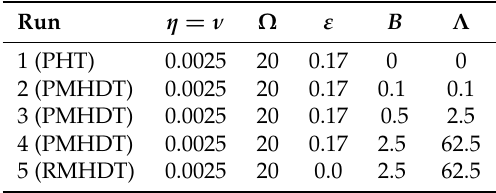
Table 1. Summary of the parameters for the different runs performed: precessing hydrodynamic turbulence (PHT), precessing MHD turbulence (PMHDT), rotating MHD turbulence